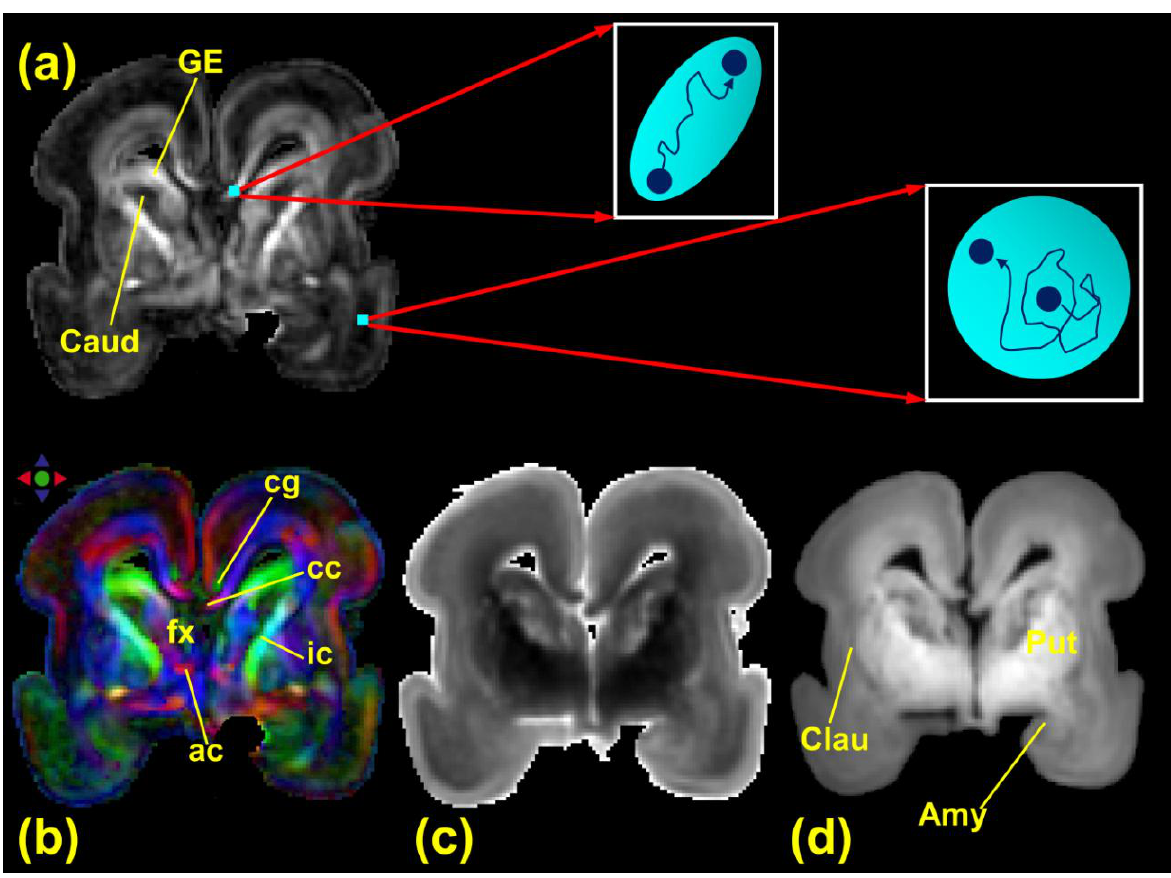
FIGURE 1 . (a) FA map, (b) directionally encoded color map, (c) ADC map, and (d) aDWI, all derived from DTI and shown in a coronal slice of a 21-week fetal brain. High contrasts from DTI-derived images reveal many neural structures, including both white matter tracts and subcortical nuclei. The FA map in (a) describes the shape of the diffusion tensor, namely, how elongated a diffusion ellipsoid is. A voxel with high FA value indicates that it is characterized with a more elongated diffusion ellipsoid (left in the upper row), while a voxel with low FA value is characterized with the diffusion ellipsoid more like a sphere (right in the upper row). The blue small dots represent the water molecules and blue curves simulate the paths of the movement of water molecules. R(ed)/G(reen)/B(lue) in (b) indicate the left-right, anterior-posterior, and superior- inferior structural orientation, respectively. aDWI in (d) reveals the subcortical neural